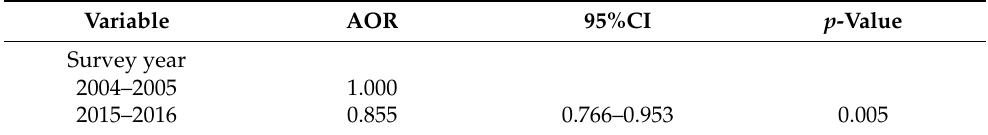
Table 3. Decline in women’s anemia in relation to other factors using TDHS 2004–2005 and TDHS